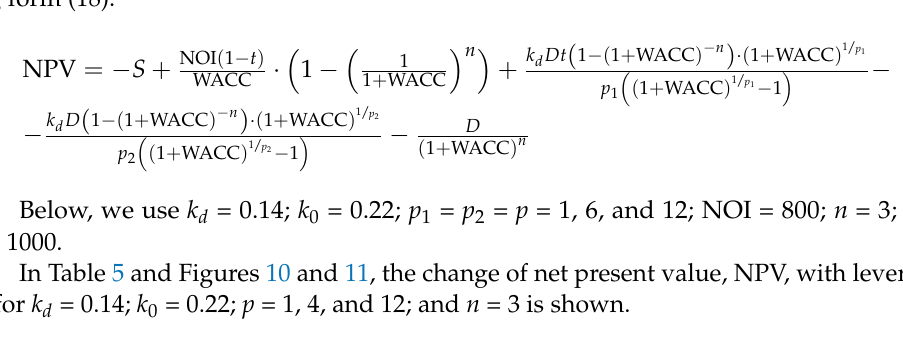
Table 5. Change of net present value, NPV, with leverage, L , for k d = 0.14; k 0 = 0.22; p = 1, 4, and 12; and n = 3.